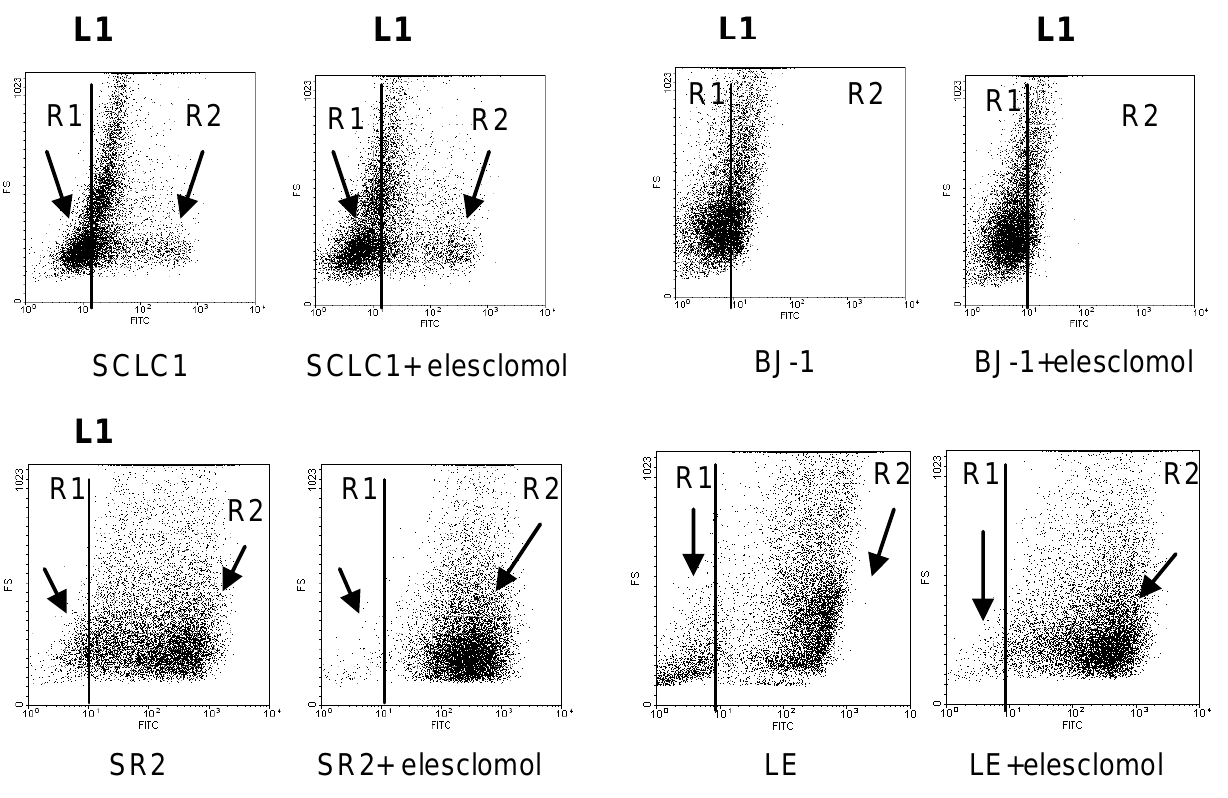
Figure 6. Flow cytometry analysis of H O in lung cancer cell lines detected by APFB 2 2 probe indicated that there are 2 populations of cell: R1 (low H O ) and R2 (high H O ). 2 2 2 2 The levels of H O decreased in parental lines (SCLC1) and normal cells (BJ-1) when 2 2 treated with 10 nM of elesclomol for 24 h as indicated by the population of cells moved to the left of line L1 (more R1 population). SR2 and LE have more R2 population than cisplatin sensitive cells. Treatment with elesclomol increased the level of H O production 2 2 in the resistant cell line SR2 as well as in primary culture, LE as indicated by the shifting of R1 population to R2. Each dot plot is representative of three experiments (average P < 0.005; R1 vs.